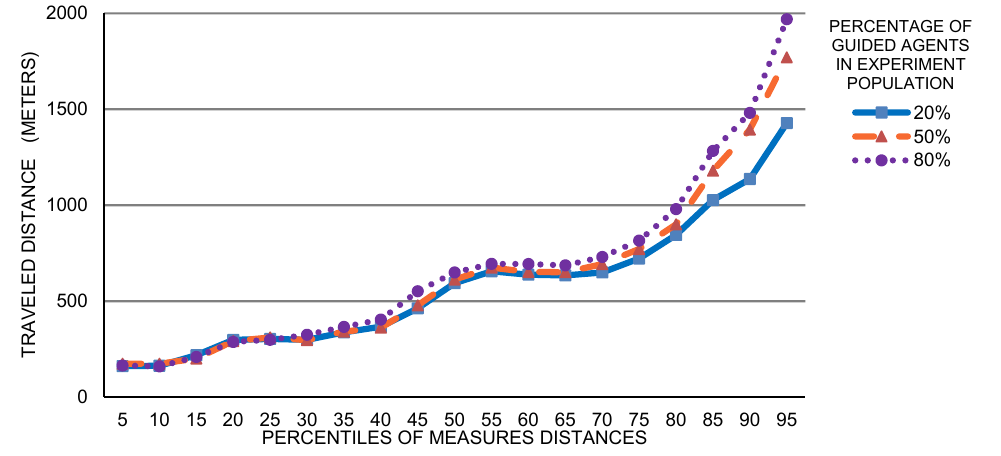
Figure 7. Difference in traveled distance, as expressed by the difference of same percentile values of the ‘Explorer’ and ‘Guided’ populations.